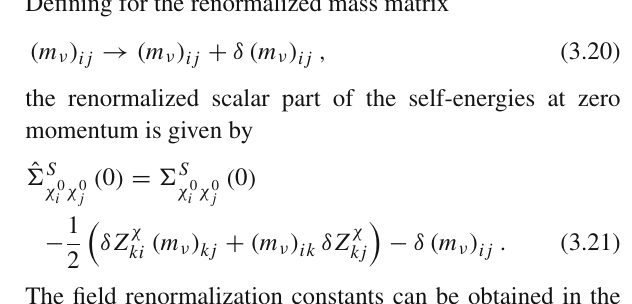
Fig. 2 Generic Feynman diagrams for the tadpoles T h different scalar and fermionic two- and three-point